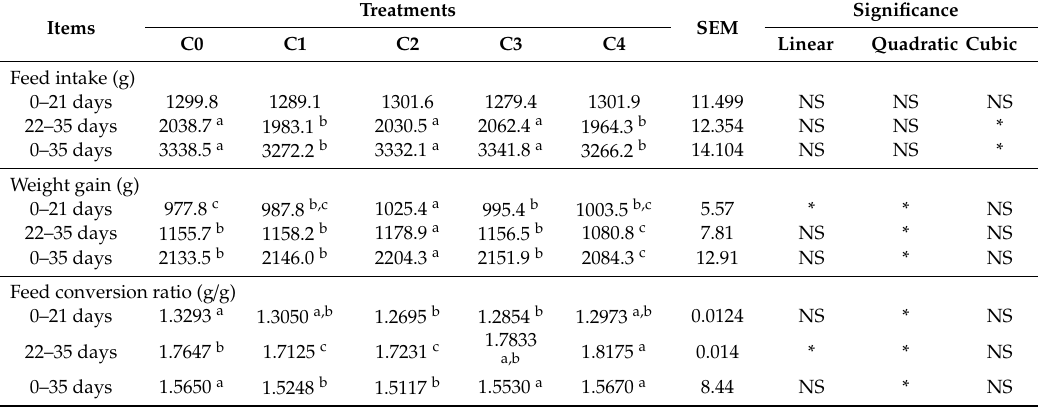
Table 2. E ff ect of chromium propionate in broiler growth